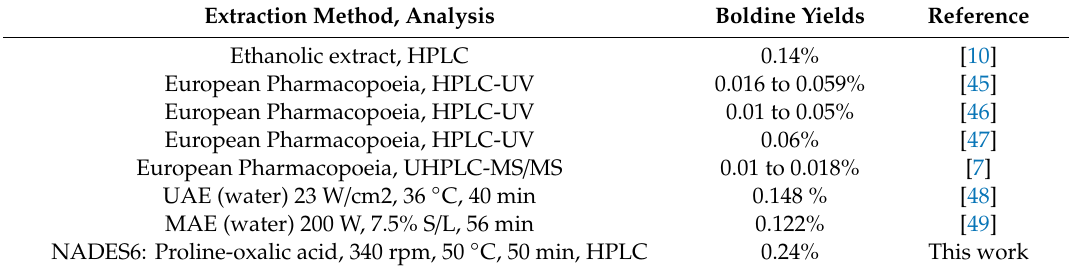
Table 4. Bibliographic data on the efficiency of various methodologies regarding boldine recovery from P. boldus.